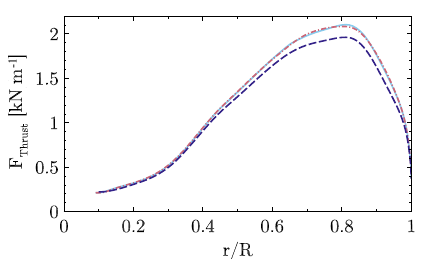
Figure B2. Influence of boundary layer transition on the sectional thrust force. Fully turbulent k – ω –SST (dashed), γ – Re θ – k – ω –SST (solid), e N – k – ω –SST (dashed dot).